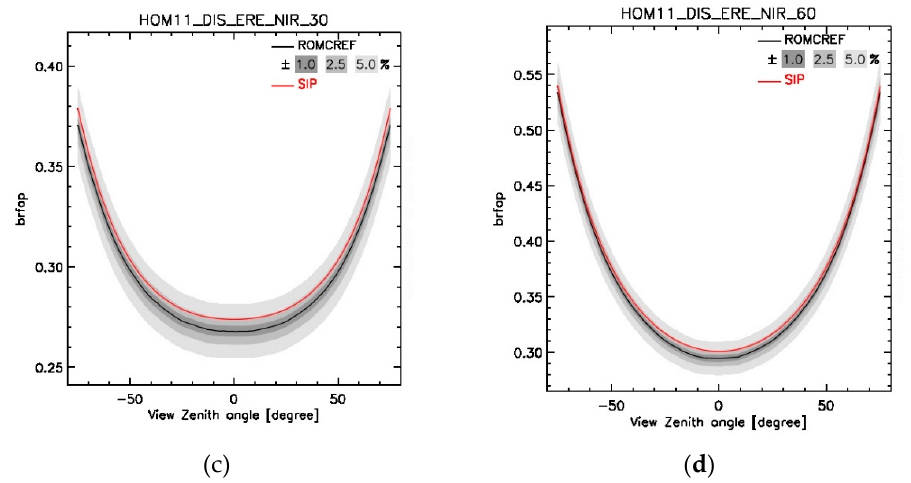
Figure 2. The bidirectional reflectance factor (BRF) of the SIP model in the red ( a ) and near infra-red (NIR) bands with the solar zenith angle at 0° ( b ), 30° ( c ), 60° ( d ) in the orthogonal plane evaluated by the RAMI On-line Model Checker (ROMC) reference dataset (ROMCREF). “HOM11” is the number of the standard RAMI scene, “DIS” represents the discrete medium of the leaves, “ERE” represents the erectophile leaf angle distribution (LAD) type, and “OP” means the orthogonal plane.